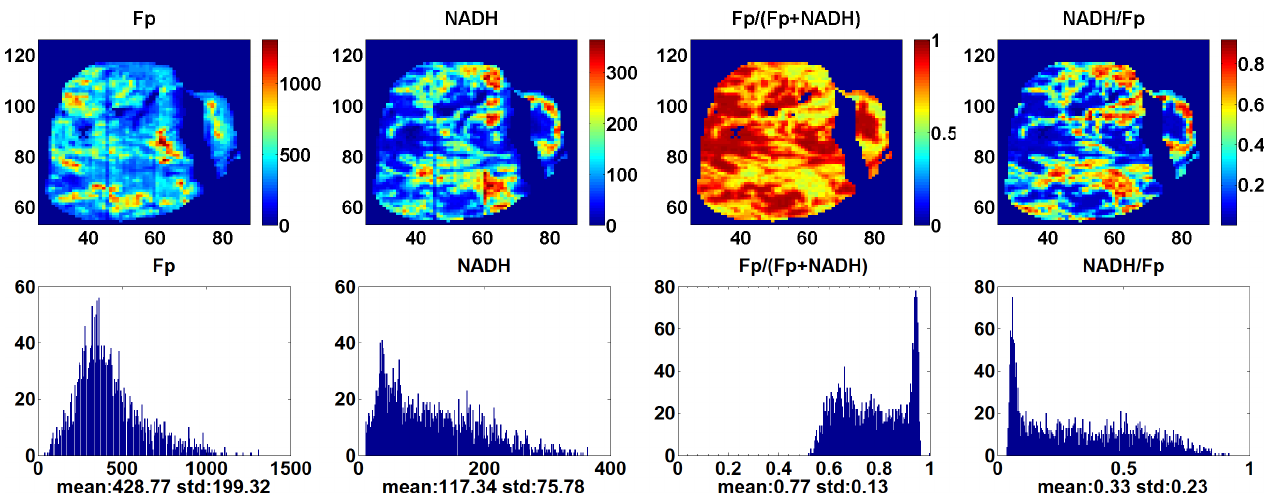
Fig. 4. Typical redox images and corresponding histograms of the largest tumor in the p53 (cid:1) = (cid:1) group. The spatial resolution is 200 (cid:1) m and the section depth is 1400 (cid:1) m . The tumor size looks similar as the tumor in Fig. 3 because of the di®erence of section depth (The image size gets larger at deeper section